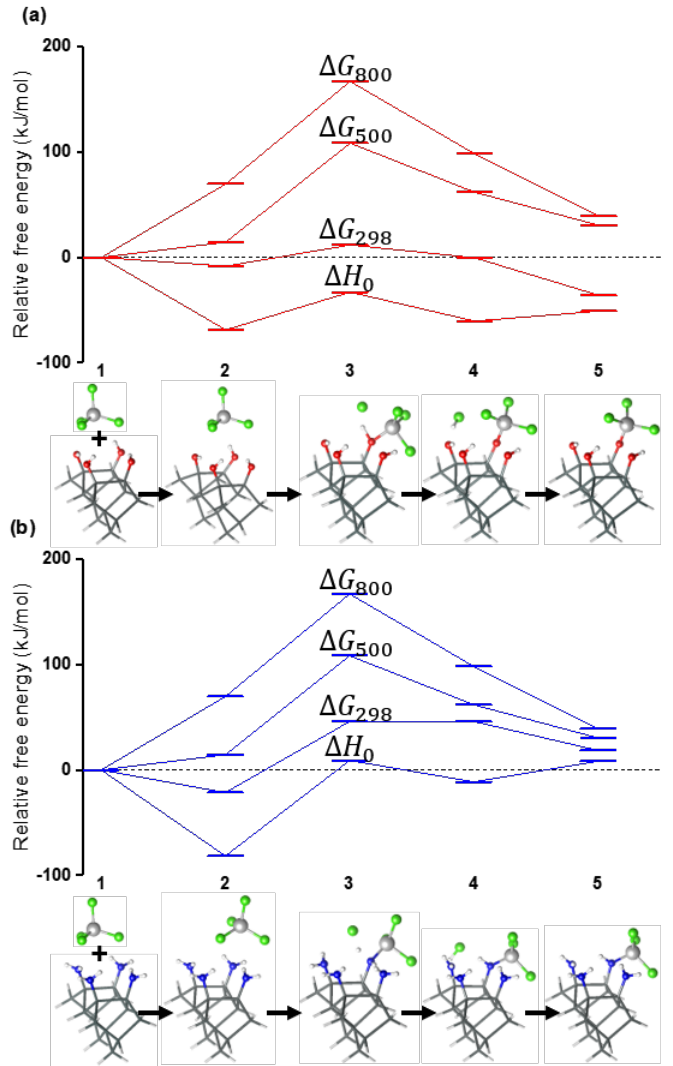
Figure 3. Potential energy surface ( ∆ H 0 ) and Gibbs free energy surfaces at 298 K ( ∆ G 298 ), 500 K ( ∆ G 500 ), 800 K ( ∆ G 800 ) for the initial adsorption of TiCl 4 : ( a ) on –OH functionalized Si surface; and ( b ) on –NH 2 functionalized Si surface. ((1) Before adsorption; (2) molecular adsorption; (3) first transition state; (4) product complex; and (5) desorption of HCl)